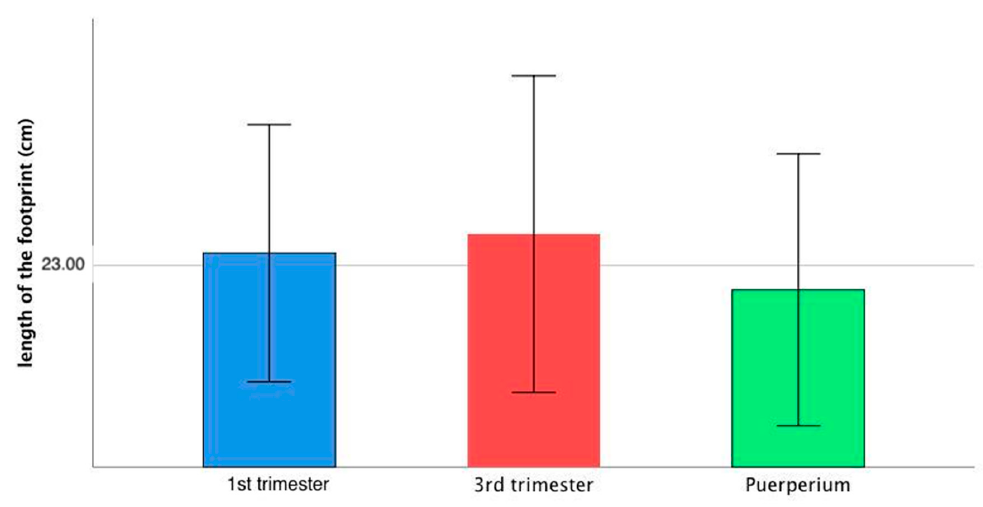
Figure 3. Changes in foot length during pregnancy and puerperium.